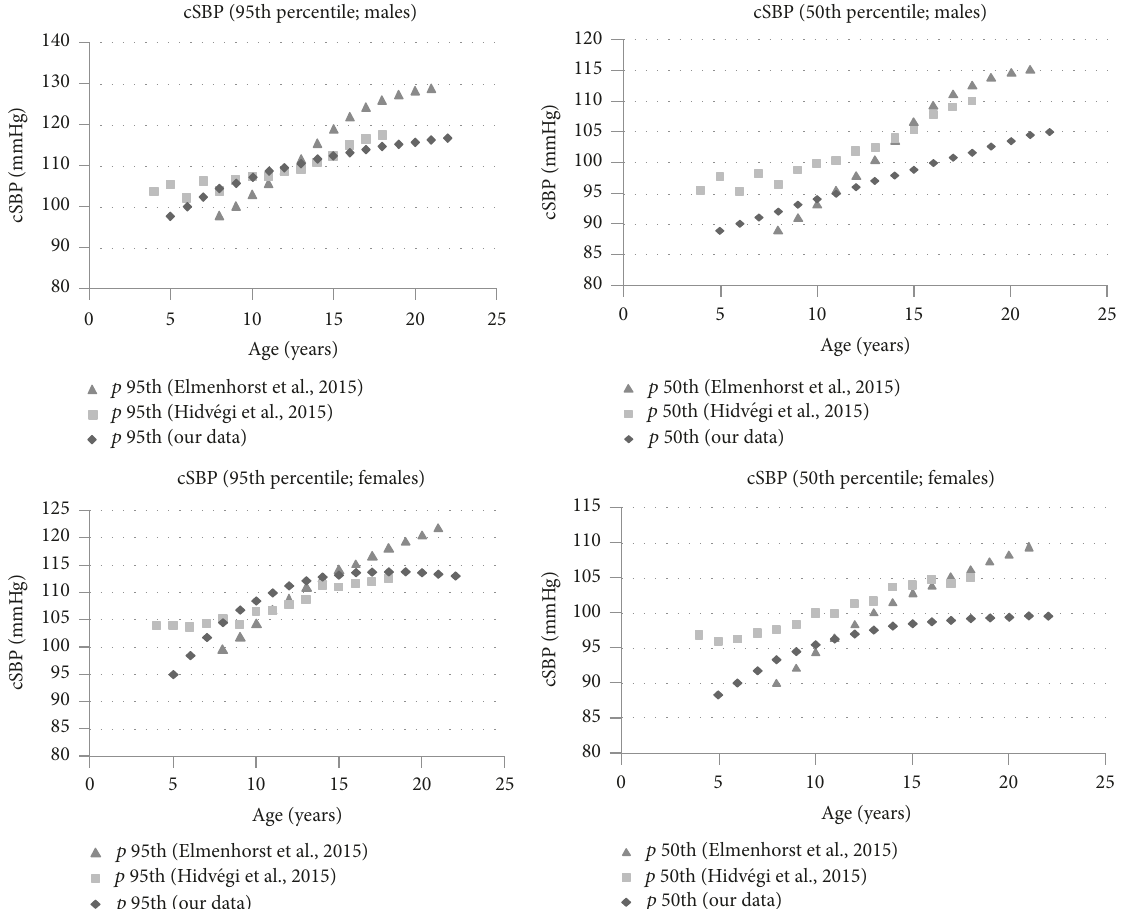
Figure 4: Age specific aortic systolic blood pressure (cSBP) percentiles 95th and 50th obtained in males and females of the Argentinean population compared with European date previously reported.